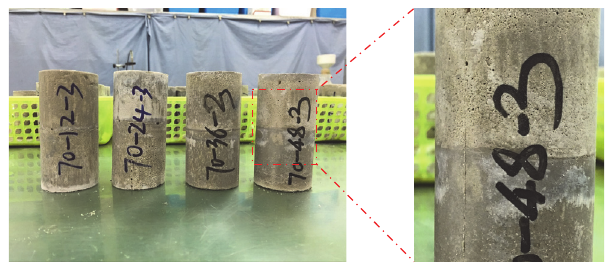
Figure 4: Layered cemented backfill specimens.